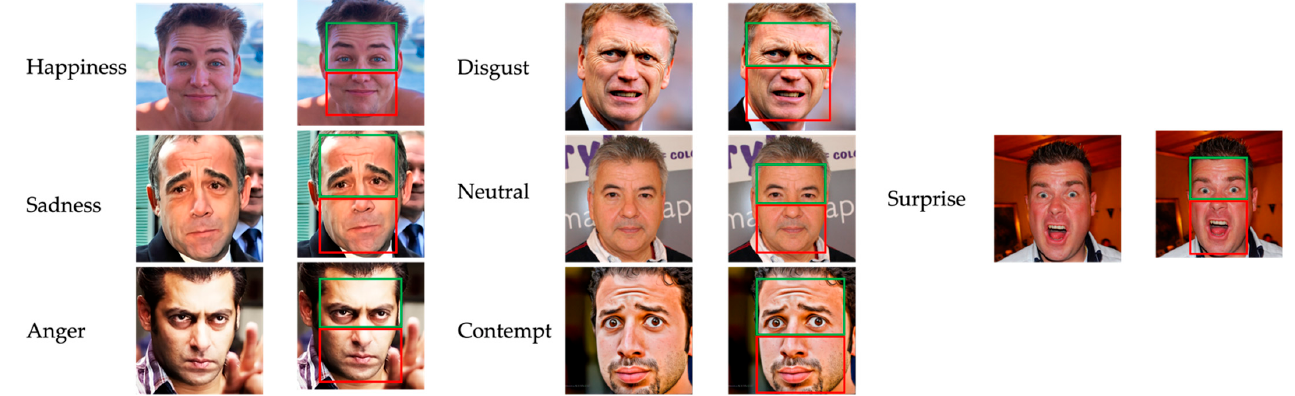
Figure 1. Example of seven facial emotions for upper and lower parts of the face: green rectangle box for upper part; red rectangle box for lower part.